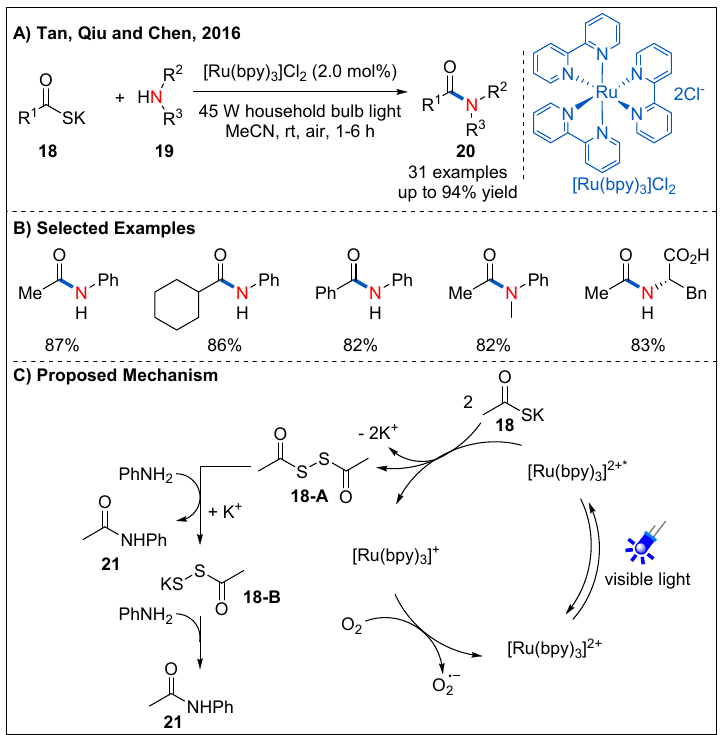
Figure 9. Selective amide constructions from potassium thioacids.